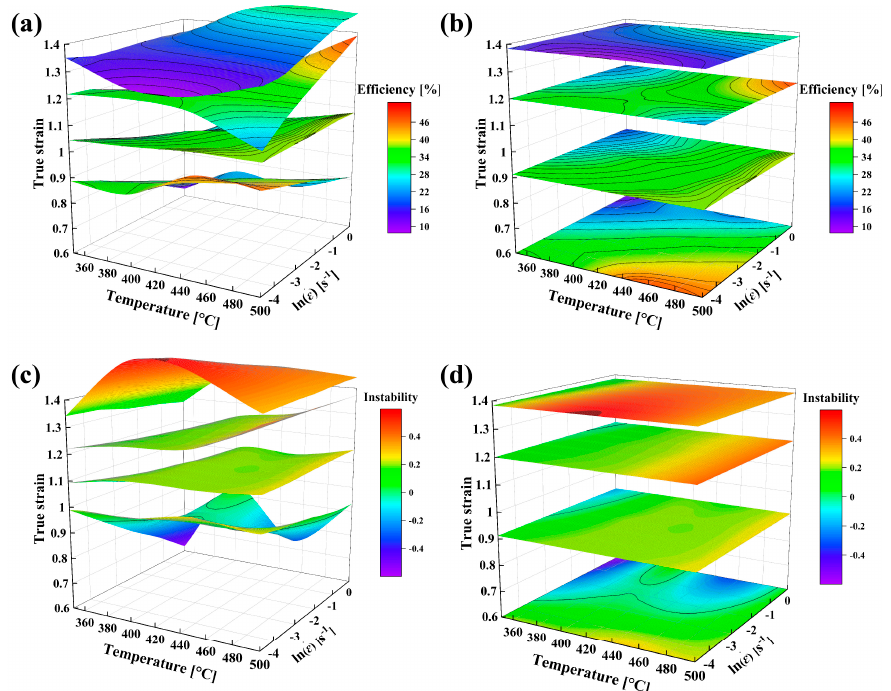
Figure 3. ( a , b ) The 3D power efficiency map, ( c , d ) 3D instability map of Al–4.30 Mg. The alloy as a function of true strain from 0.69 to 1.38 (The left ones are 3D curved surface maps, while the right ones are the corresponding projection in (cid:1846) − ln (cid:2013)(cid:4662) plane). As shown in Figure 3a,b, the 3D power dissipation map at a true strain of 0.69–1.38 and its projection in (cid:1846) − ln (cid:2013)(cid:4662) plane is established. In addition to temperature and strain rate, the